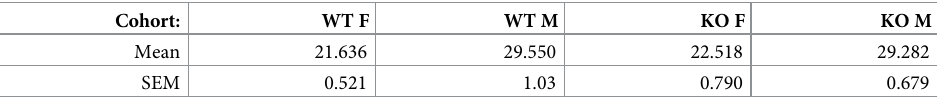
Table 1. Body weights (g) of animal subjects in this study.